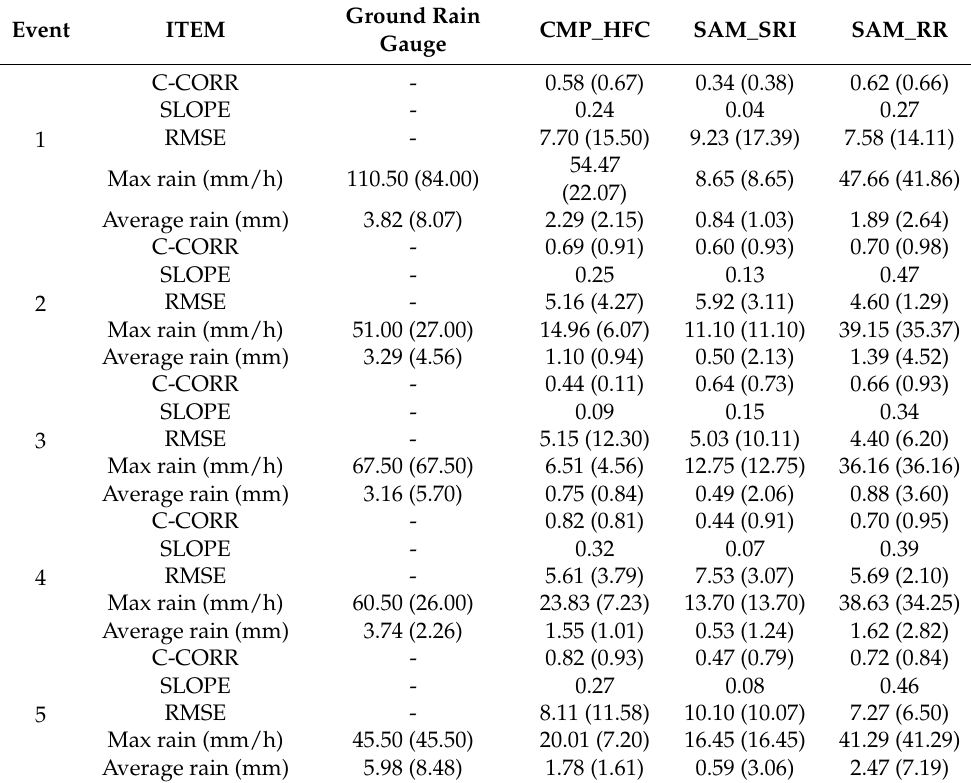
Table 2. Results of accuracy analysis for 1 h accumulated rainfall from radar